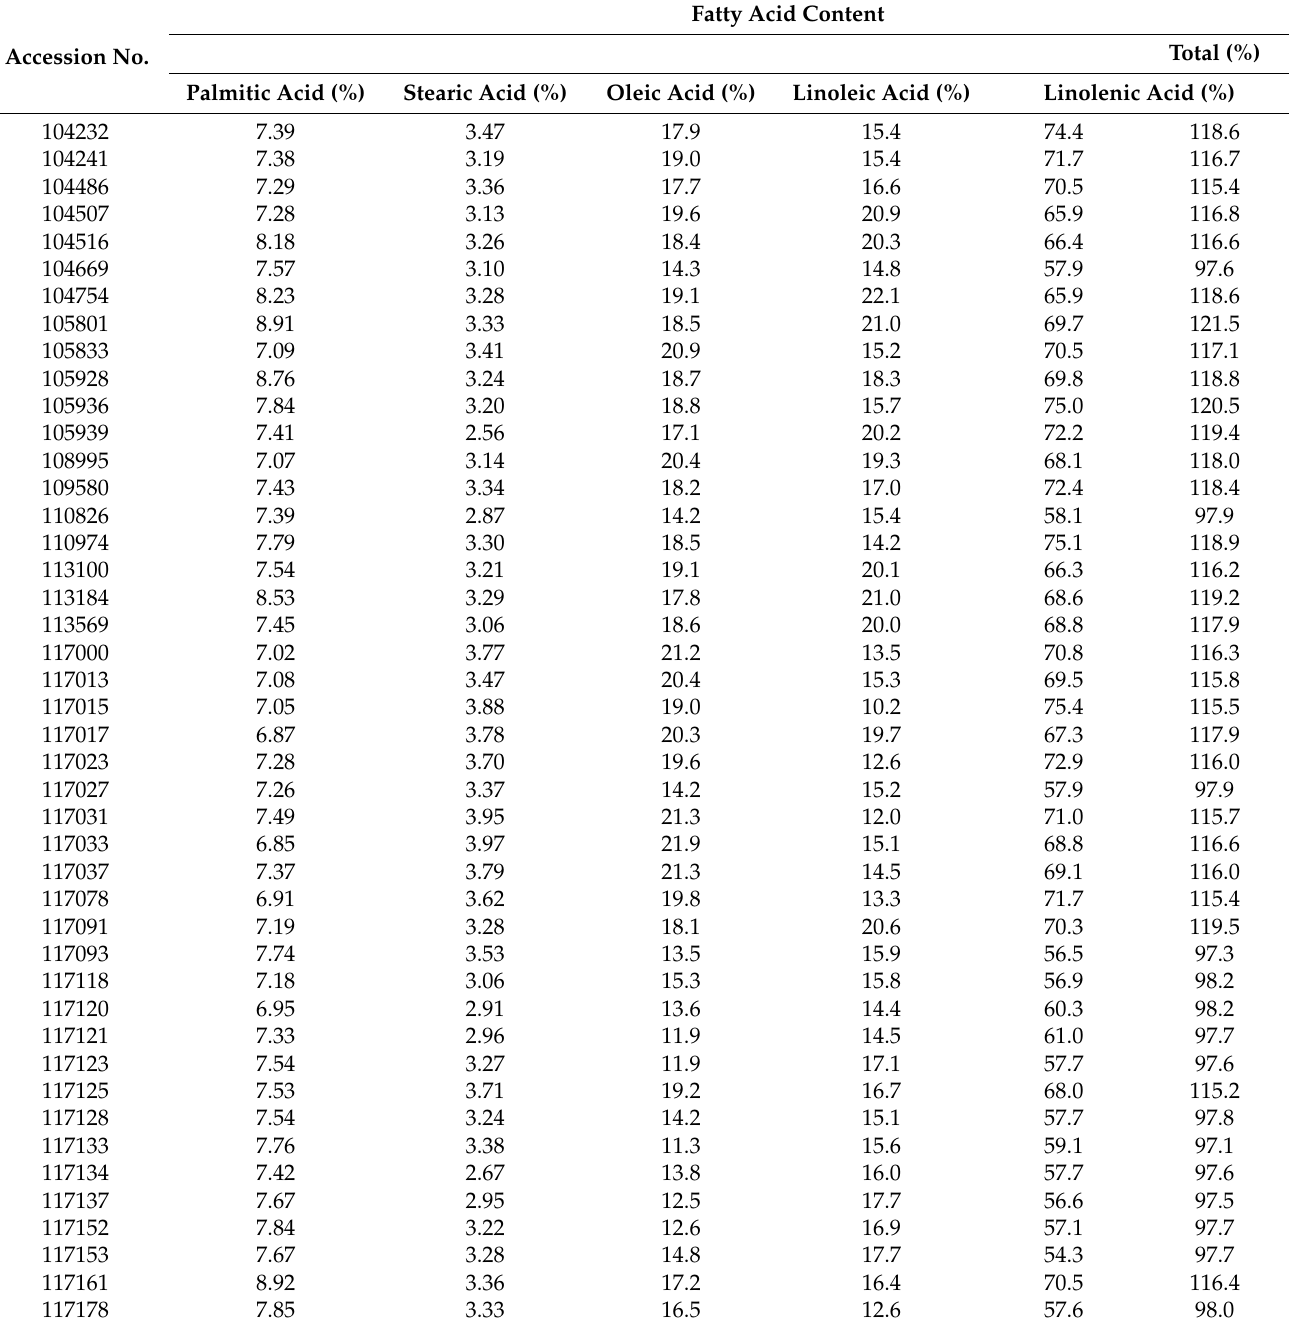
Fatty Acid Content